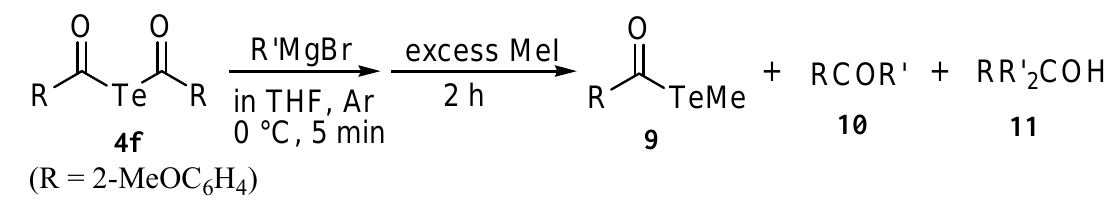
Table 5. Reactions of (2-MeOC